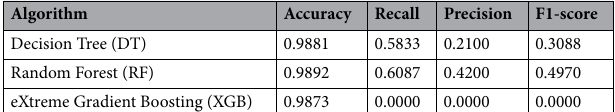
Table 2. Performance evaluation on original dataset.